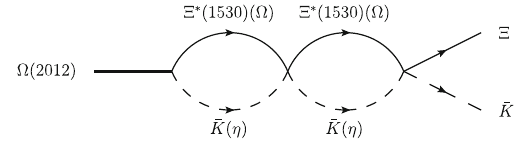
Fig. 3 Diagram for the three body decay of (cid:2)( 2012 ) → ¯ K (cid:3) ∗ ( 1530 ) → ¯ K